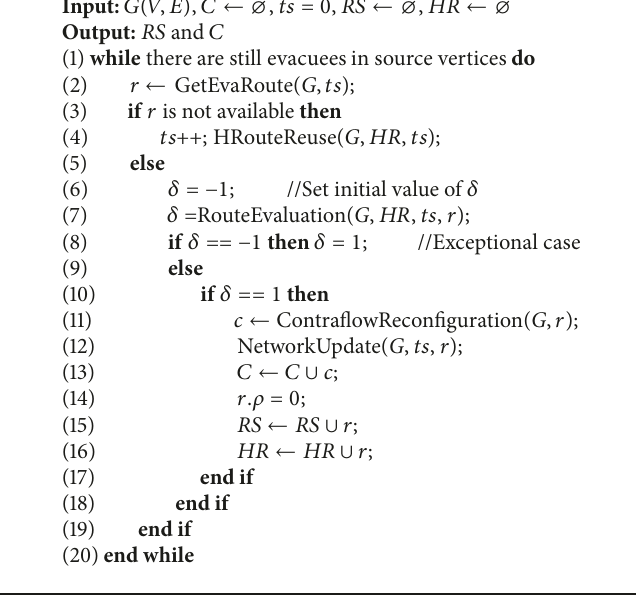
Algorithm 1: CC-Adap